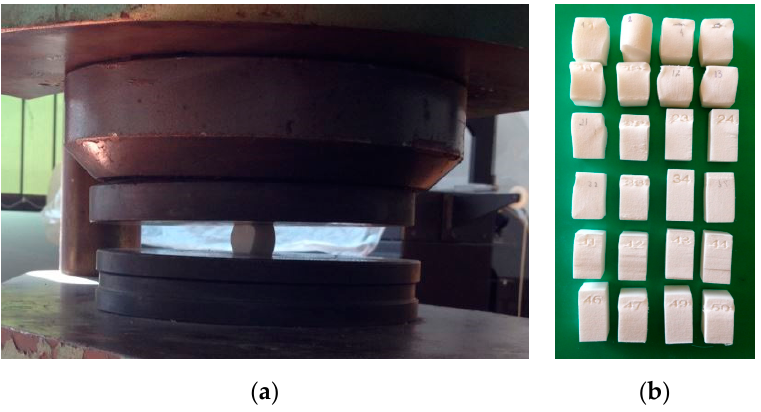
Figure 2. Compressive tests performed in the case of samples made using the DTM Sinterstation 2000 equipment: ( a ) testing equipment on the ZD 40 Tension-Compression Testing Machine; ( b ) 3D-printed samples produced by SLS after the compressive test experiment.